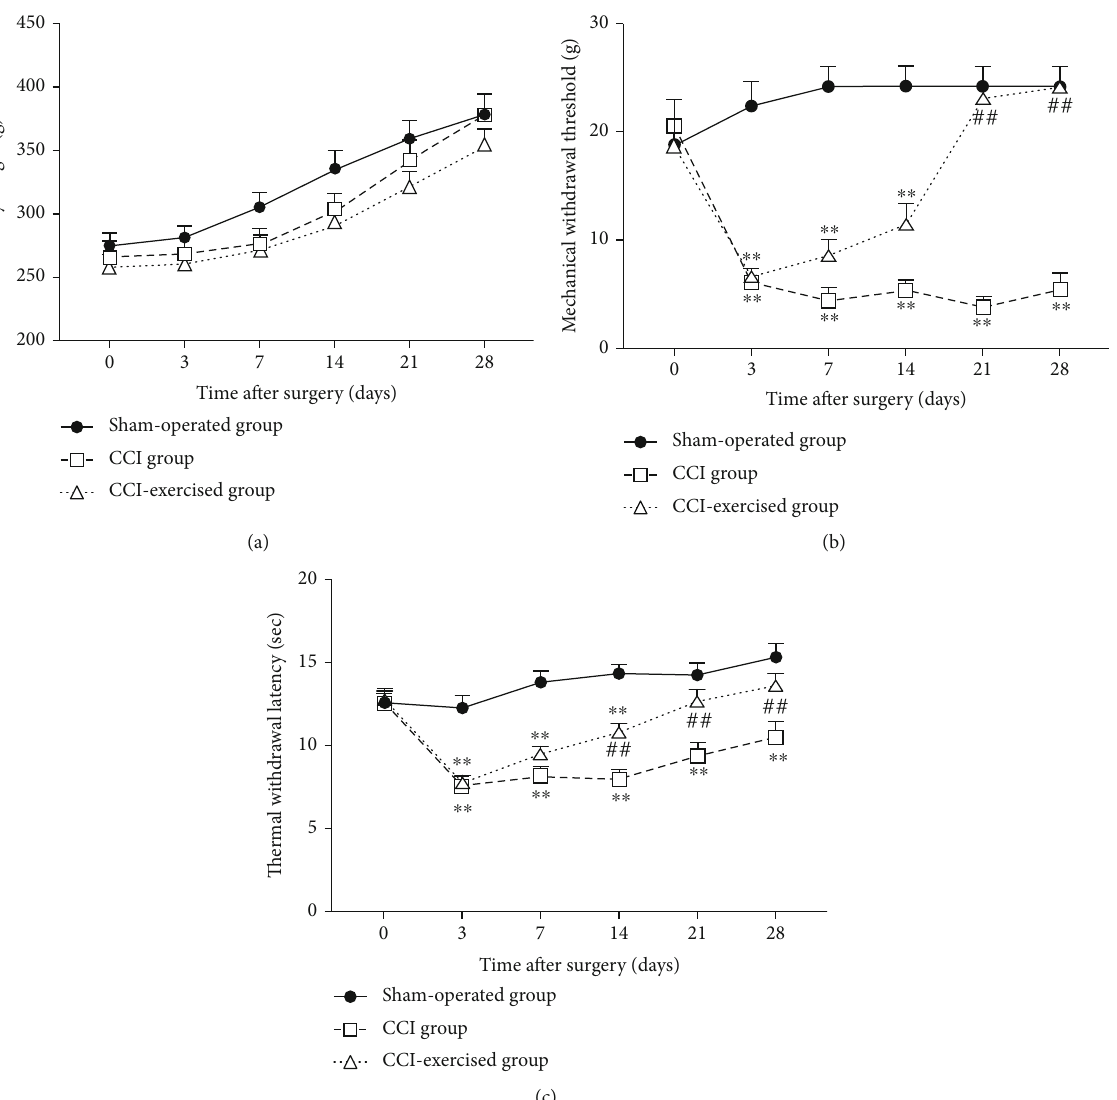
Figure 3: Body weight and nociceptive behavior in di ff erent time courses. (a) Time courses of body weight, (b) mechanical withdrawal threshold, and (c) thermal withdrawal latency. Analyses of data were done by two-way ANOVA for repeated measures. Values indicate the mean ± standard errorof mean ( n = 6 animals/group). ∗ p < 0 : 05 and ∗∗ p < 0 : 01 , for comparisons of the sham-operated group vs. the chronic constrictive injury (CCI) group or CCI-exercised group. # p < 0 : 05 and ## p < 0 : 01 for comparisons of the CCI-exercised group vs. the CCI